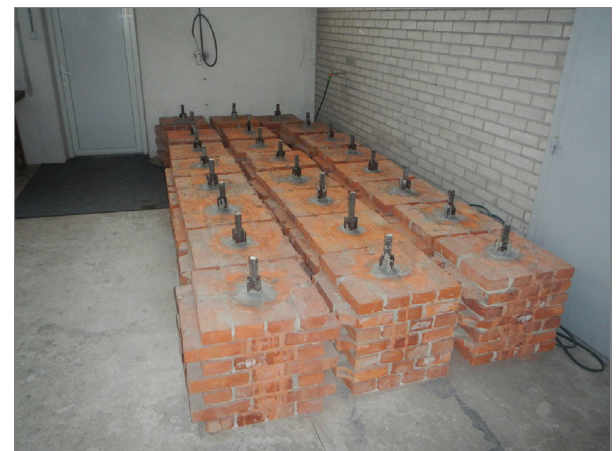
Fig. 15. Force application to specimens